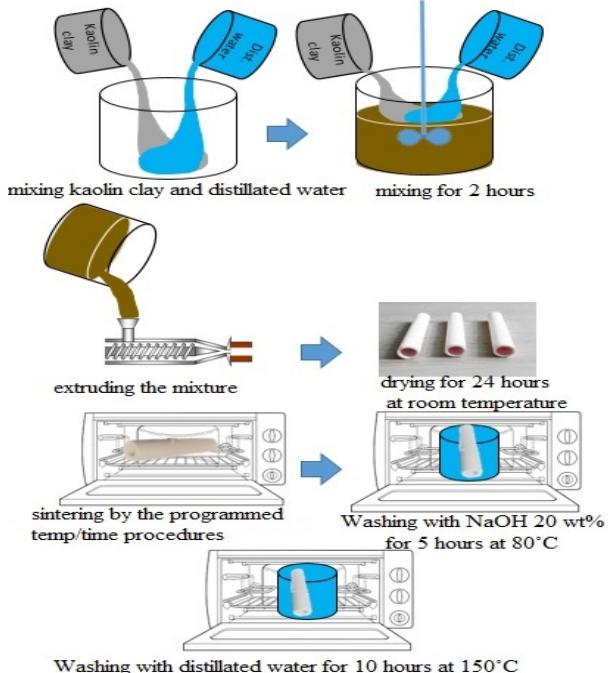
Figure 3. Schematic representation of mullite membrane fabrication.